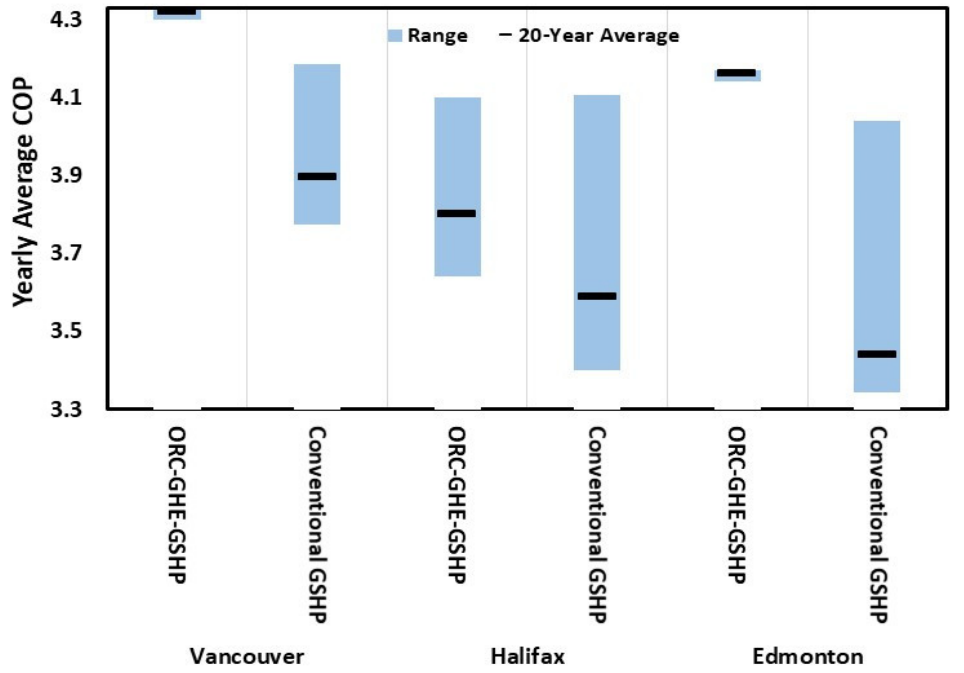
Figure 15. Average COP during the 20-year period for each city and systems.